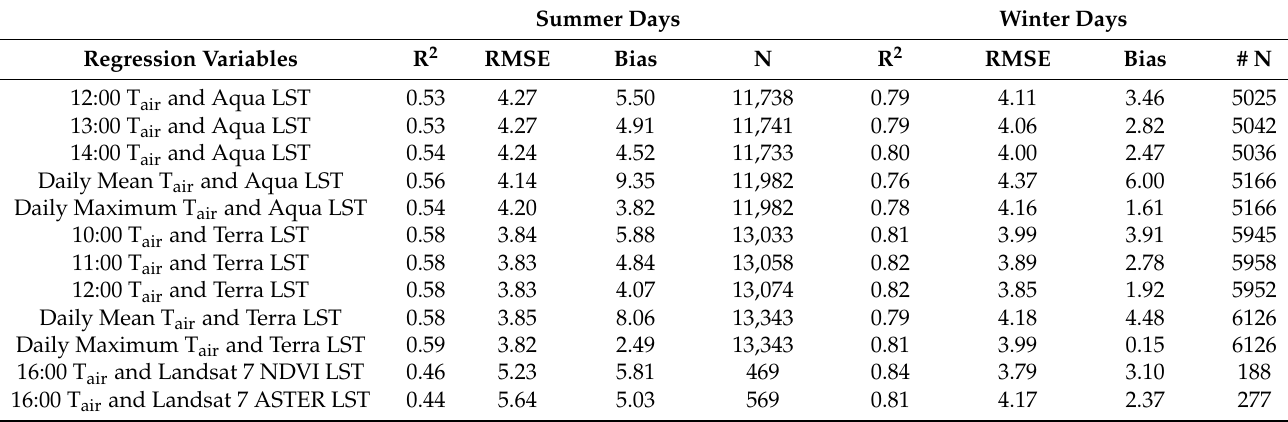
Table 4. Detailed results from regression analyses conducted using both MODIS satellites and Landsat 7 against air temperature based on urban in situ stations. All p -values are <0.001. Summer Days Winter Days Regression Variables R 2 RMSE